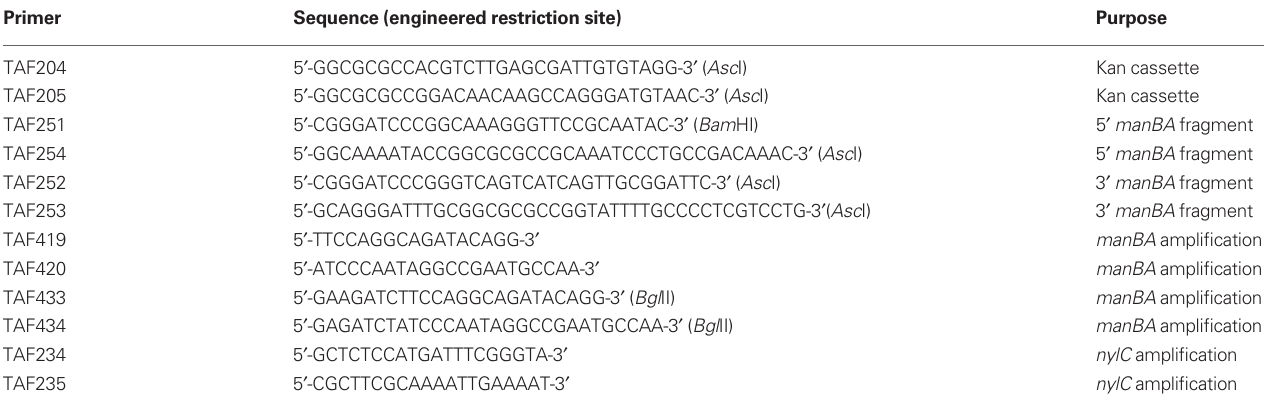
Table 2 | Primers used in this